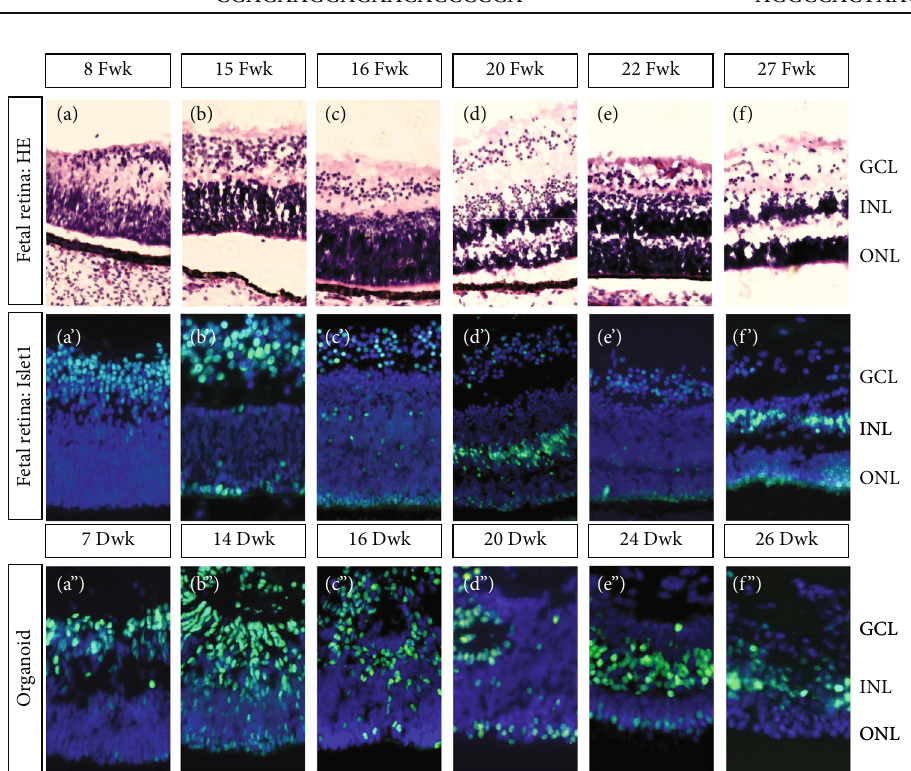
Figure 1: Lamination of human fetal retina and Islet1 dynamic expression in human fetal retina and hiPSC-derived retinal organoid. (a – f) Ganglion cell layer (GCL) fi rst developed in the human fetal retina. Next, the neuroblast layer gradually thickened and divided into an inner nucleus layer (INL) and outer nucleus layer (ONL). (a ′ – f ′ ) Islet1 was expressed in the GCL in the early stage and then appeared as a monolayer nucleus on the most outer side. Later, sporadic positive nuclei were observed in the thickening neuroblast layer and fi nally collected on the outer side of the INL. (a ″ – f ″ ) Consistent with the human fetal retina, Islet1 was expressed in the GCL fi rst in the retinal organoid. A monolayer of Islet1-positive cells was located on the apical side. In the midperiod, rosettes were detected in the organoid, disturbing lamination. Until late stages, retinal organoid was laminated and Islet1-positive cells were collected in the